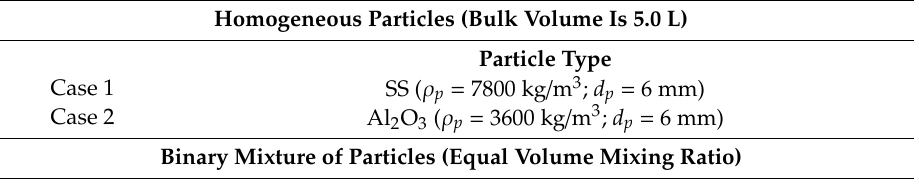
Table 1. Simulation conditions and particle properties.